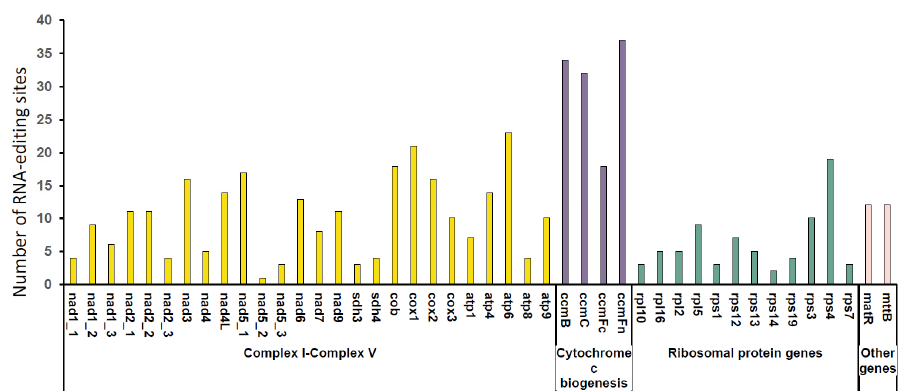
Figure 3. The number of RNA-editing sites; nad1 , nad2 , and nad5 have three copies.